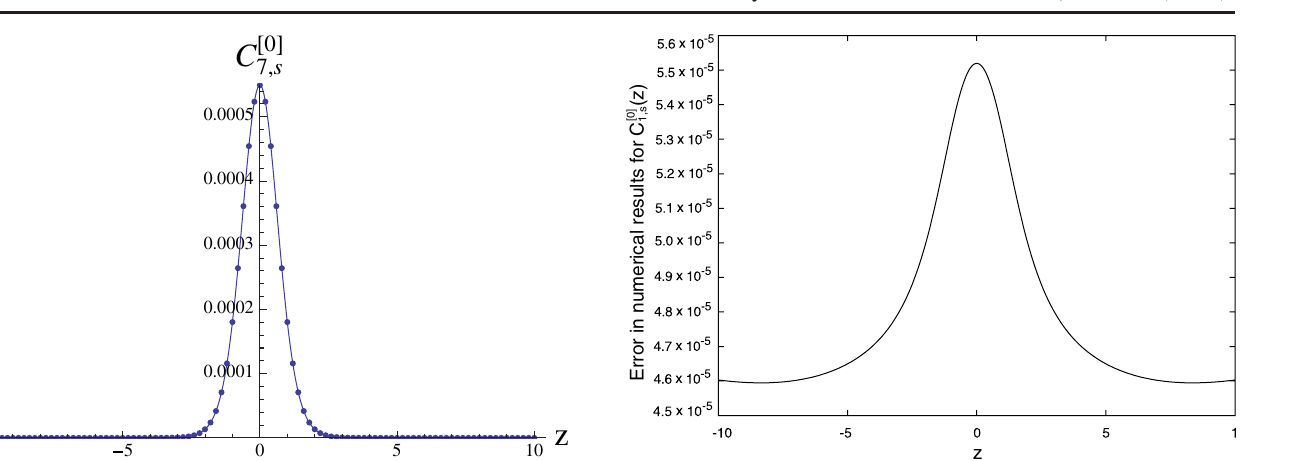
FIG. 14. Difference between exact and numerical results for ð z Þ . C ½ 0 (cid:3) 1 ;s